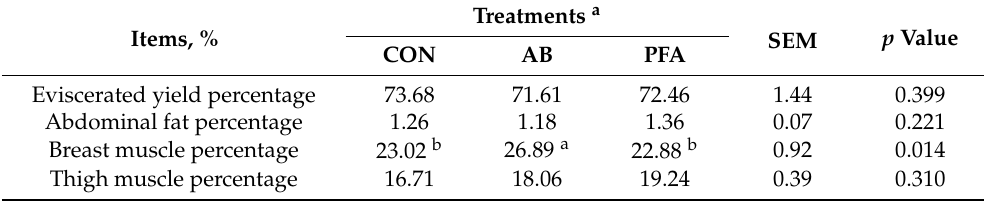
Table 4. Effects of paraformic acid (PFA) supplementation on carcass traits in broiler chickens.